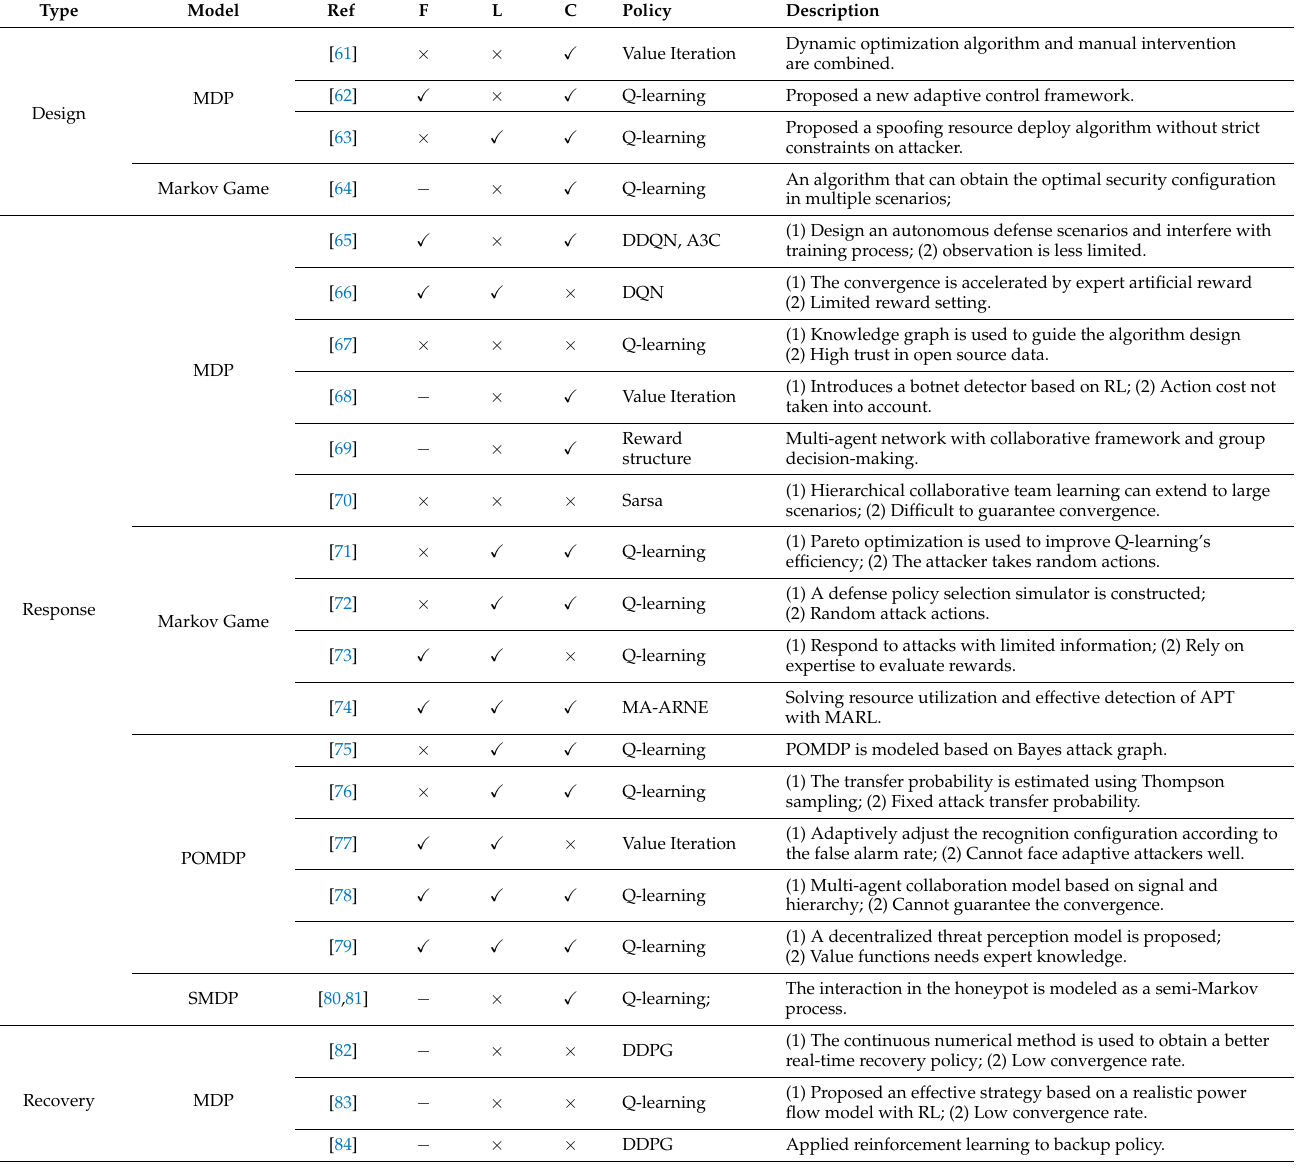
Table 2. Survey from the defender’s